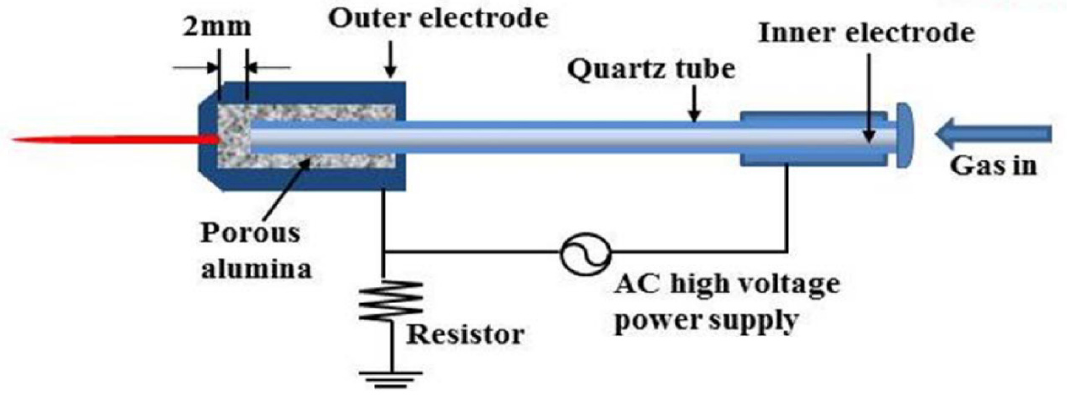
Figure 1. The schematic drawings of the non-thermal atmospheric pressure plasma jet system. Gas supplied by nitrogen gas while electrical power by AC high voltage was supplied to inner and outer electrode separated by quartz tube.